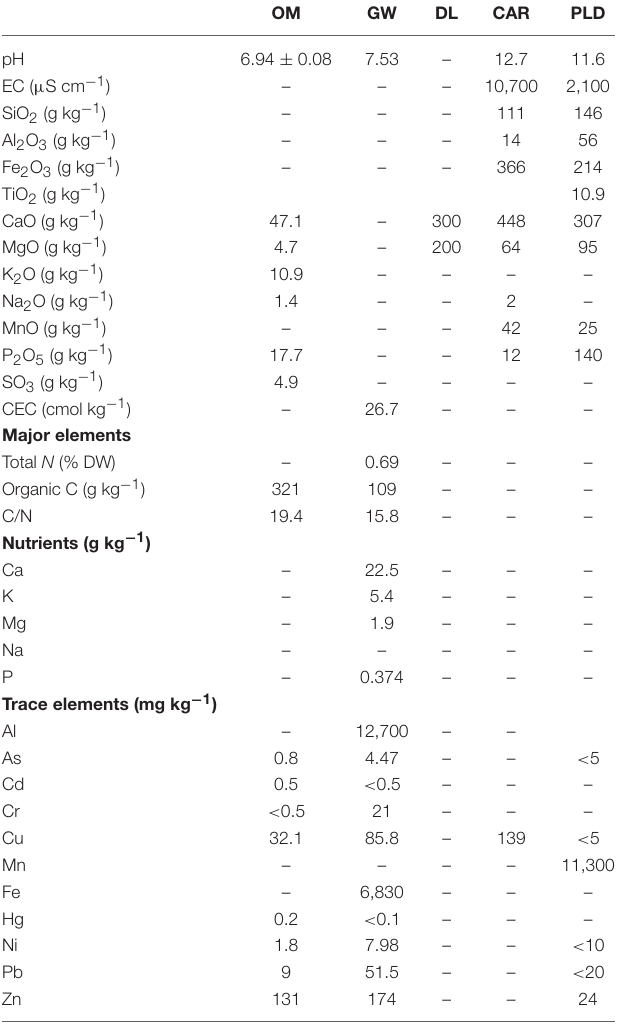
TABLE 2 | Composition and main physico-chemical properties of soil